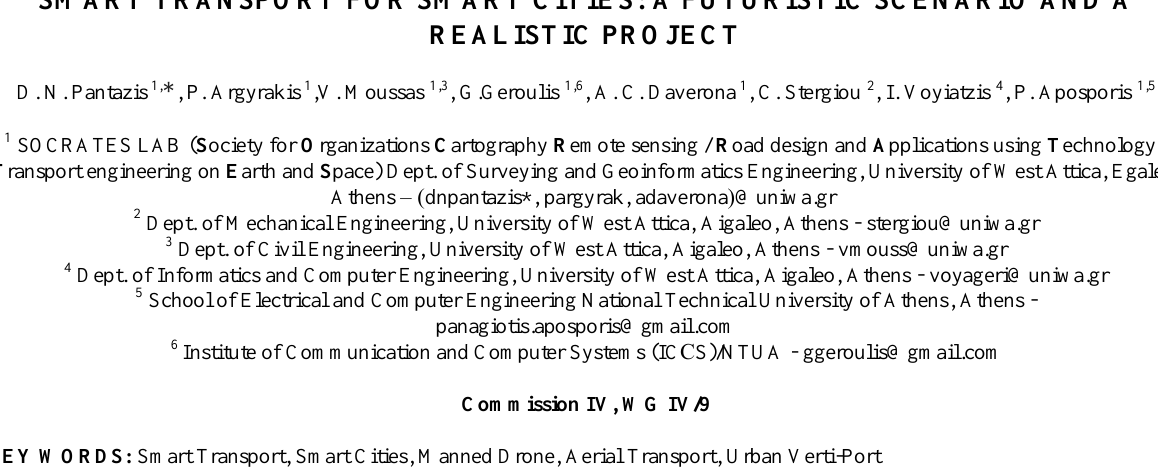
Elysium (Figure 1 B, C), fights against manned military drones,